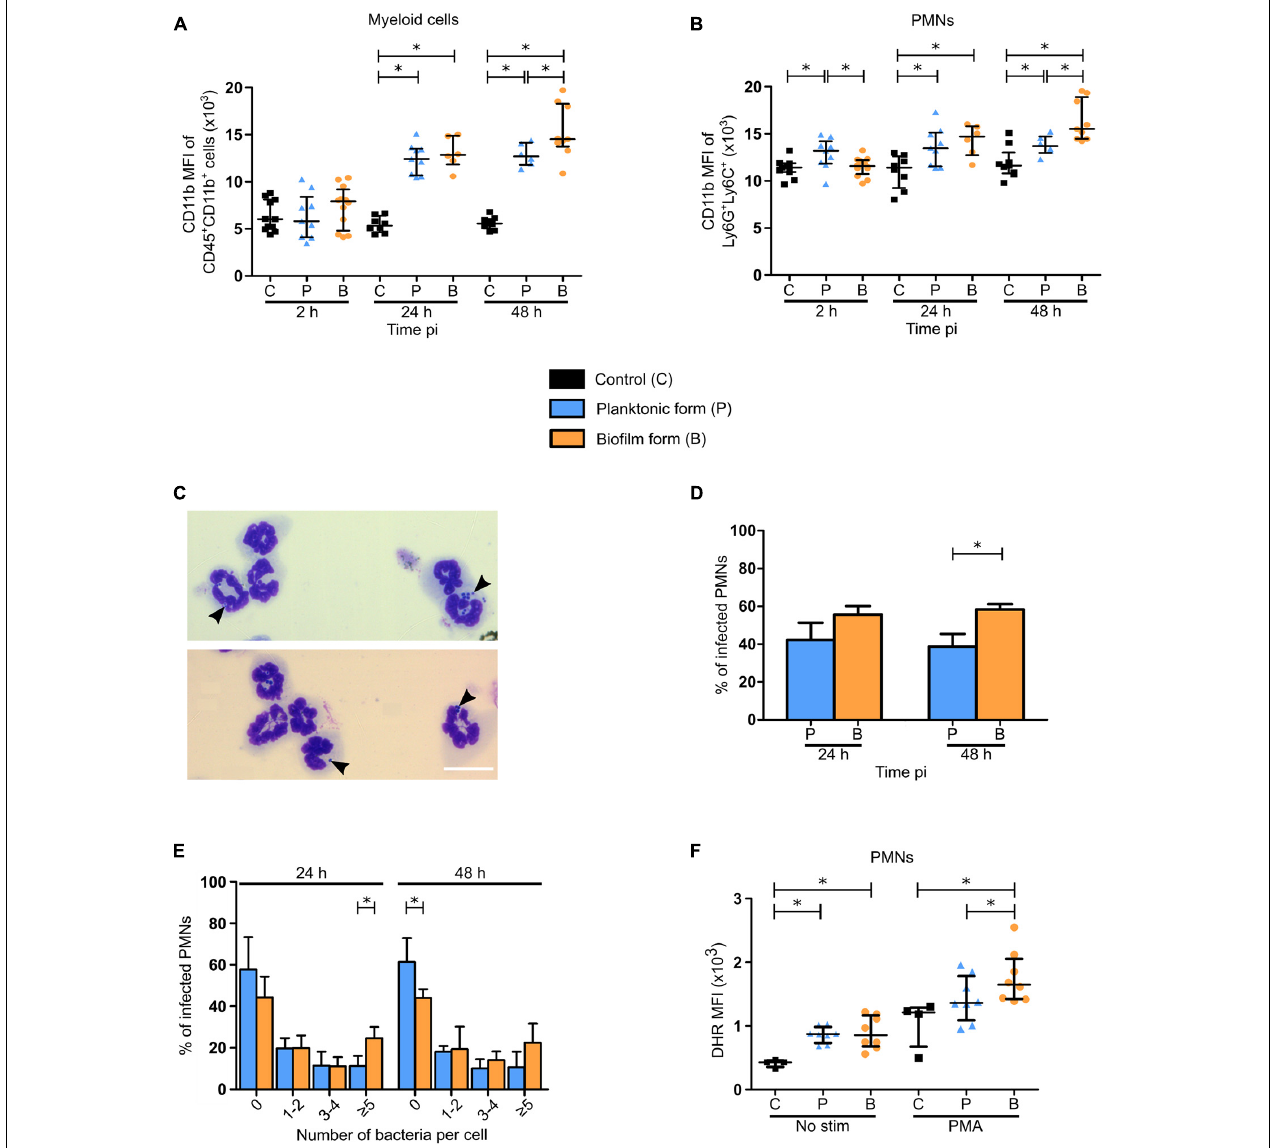
FIGURE 7 | Functional properties of neutrophils recruited in the ear pinna tissue of S. aureus infected mice. (A,B) APC-Cy7 conjugated CD11b antibody MFI of myeloid cells (CD45 + CD11b + ) (A) and PMNs (Ly6G + Ly6C + ) (B) in ear pinna tissue of control and planktonic or biofilm infected mice, from 2 h pi to day 2 pi (median ± IQR, number of mice: N C = 8–11, N P = 6–9, N BF = 6–12, from at least 3 different experiments, Mann-Whitney two-tailed test, ∗ p < 0.05). (C) Transmitted light images of CD11b + cells, following isolation from ear pinna tissue onto glass slides and MGG staining, show neutrophils harboring intracellular bacteria. Representative images are shown from planktonic infected WT C57BL/6J mice at 24 h pi. (D) Percentage of PMNs containing intracellular bacteria assessed at 24 and 48 h pi (mean ± SEM, number of cells: N P = 223–238, N BF = 232–338, from at least 3 different experiments, Mann-Whitney one-tailed test, ∗ p < 0.05). (E) Percentage of PMNs containing 0, 1–2, 3–4, or 5 or more intracellular bacteria assessed at 24 and 48 h pi (mean ± SEM, number of cells: N P = 223–238, N BF = 232–338, from at least 3 different experiments, Mann-Whitney one-tailed test, ∗ p < 0.05). (F) DHR MFI of PMNs, in the ear pinna tissue of control and planktonic or biofilm infected mice at day 2 pi, stimulated or not with PMA ex vivo in the presence of DHR, to assess NADPH oxidase activity (median ± IQR, number of mice: N C = 4, N P / BF = 8, from at least 3 different experiments, Mann-Whitney one-tailed test, ∗ p <